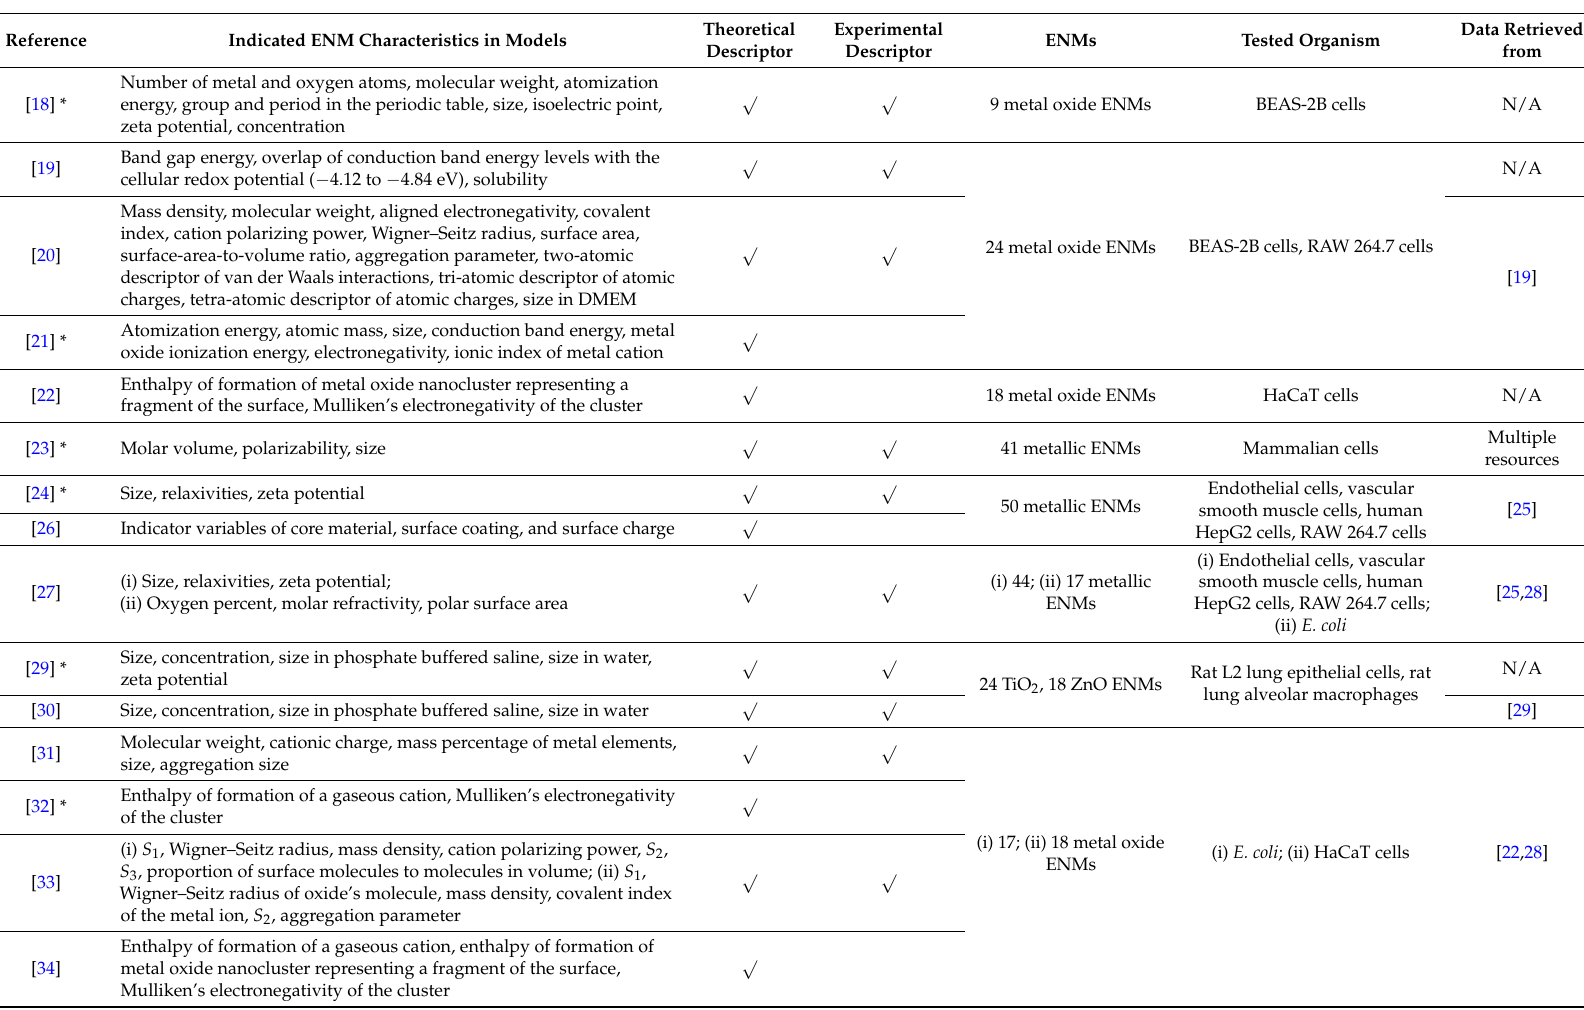
Table 1. Summary of the state-of-the-art of developed (Q)SARs and read across approaches for metal-based engineered nanomaterials (ENMs).